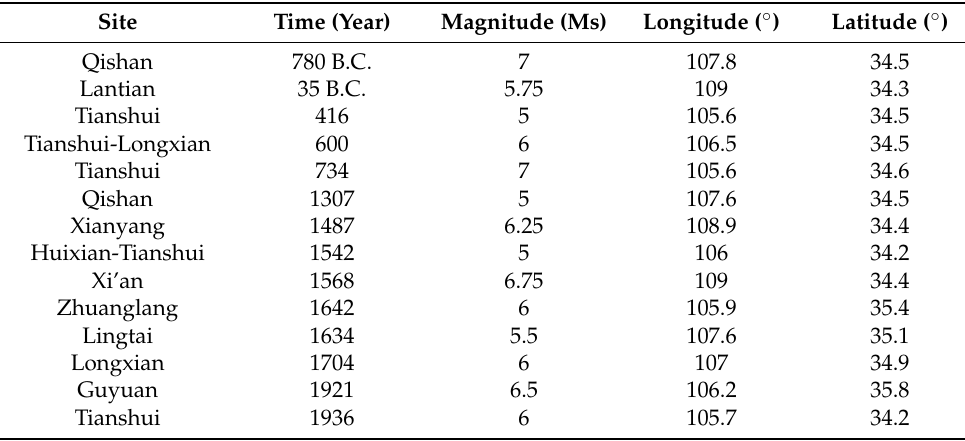
Table 2. Historical earthquake catalog of Baoji City and neighboring areas (100